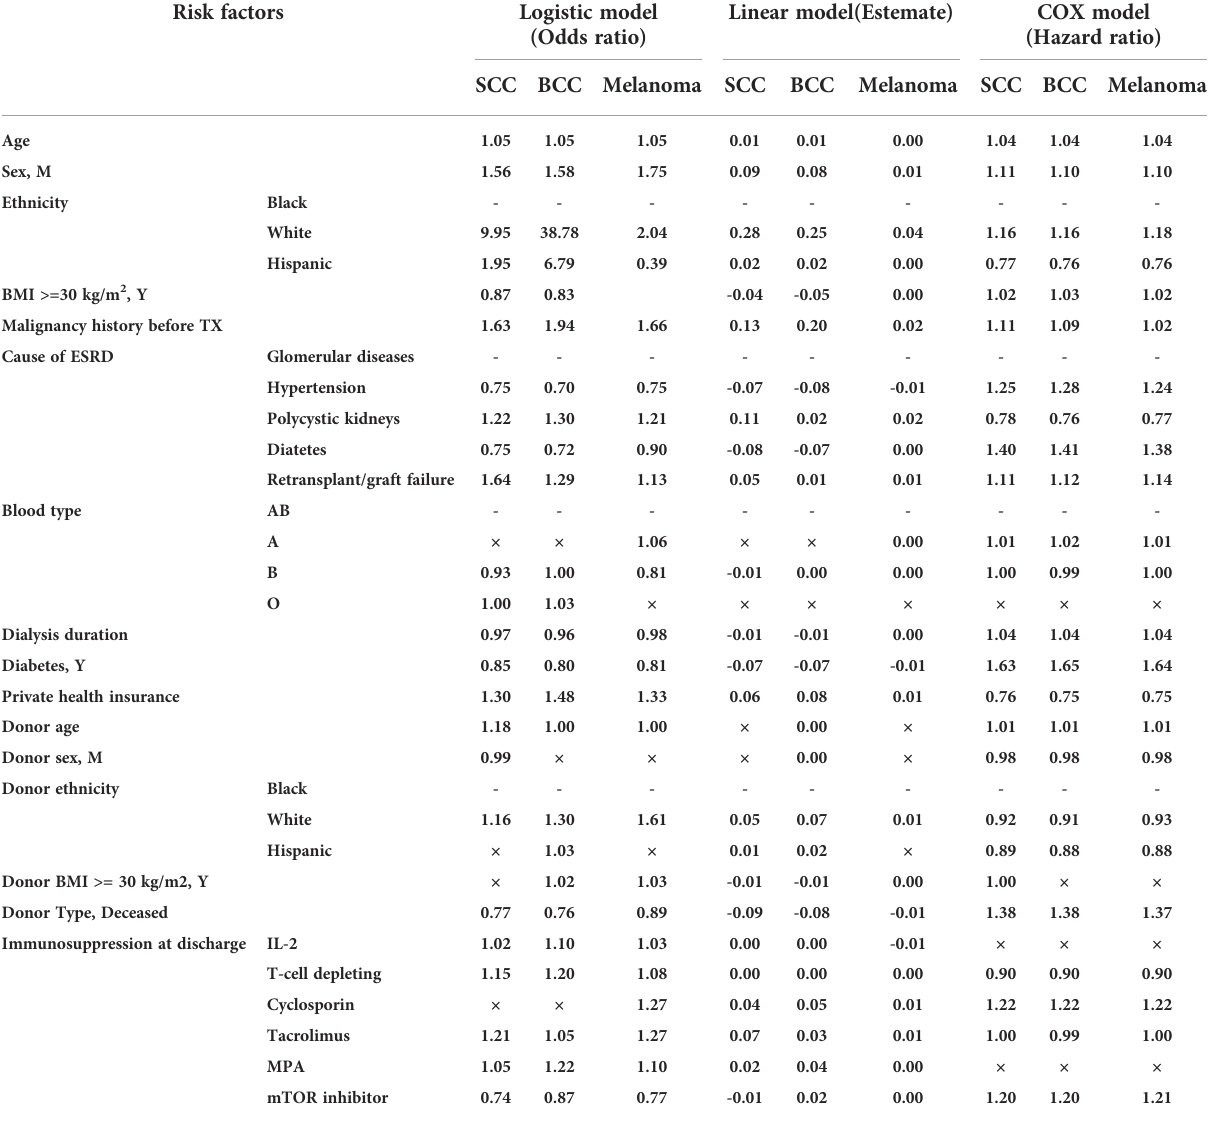
TABLE 3 Multivariable analysis of risk factors of PTSC incidence, onset, and